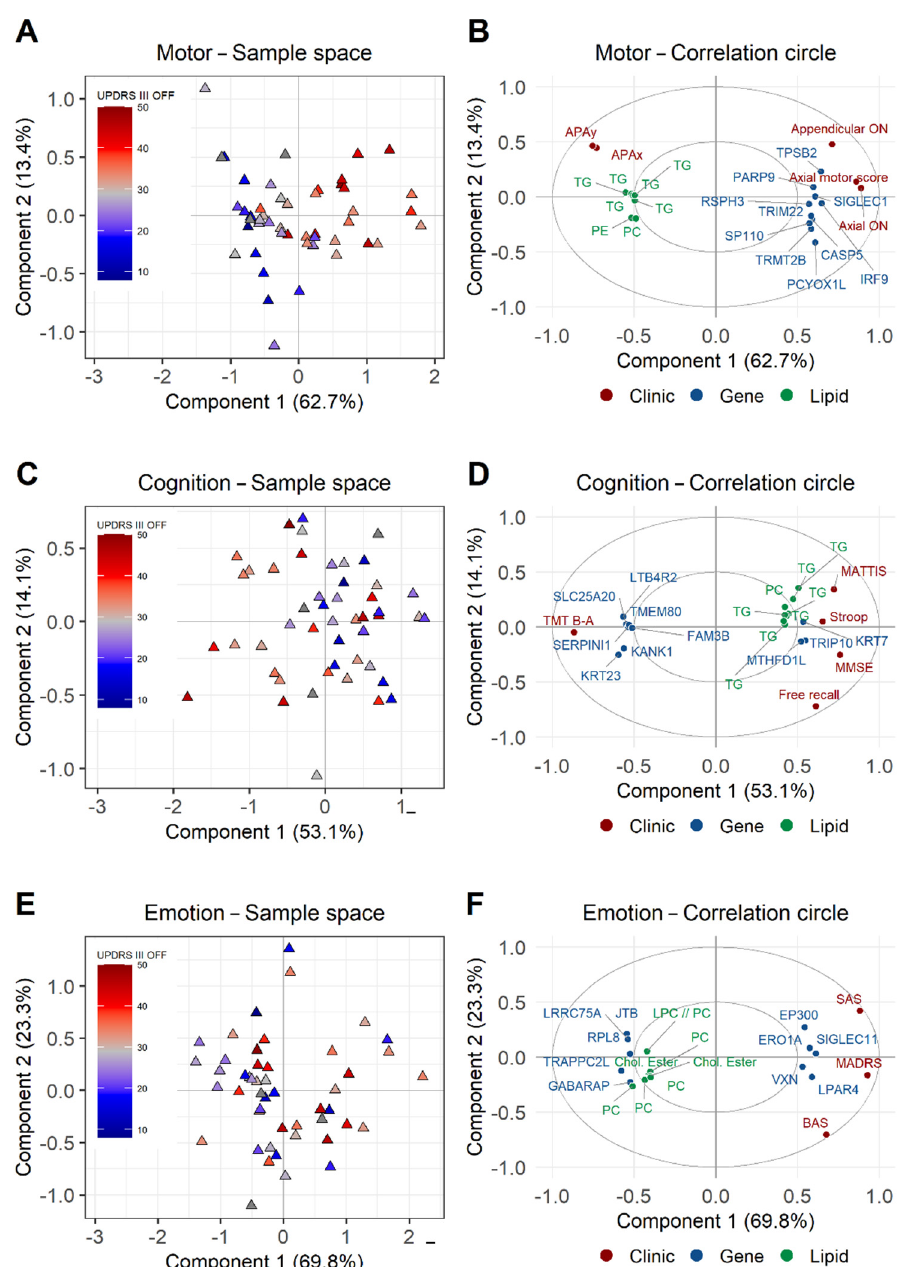
Figure 2. Sample space (left: A , C , E ) and correlation circle (right: B , D , F ) plots of the multimodal signature of lipids, genes and clinical features for each clinical model: motor ( A , B ), cognition ( C , D ) and emotion ( E , F ). The blue-to-red color gradient applied to the sample spaces is indicative of the increasing severity of motor impairment (UPDRS-III OFF) of the PD patients. The most relevant lipids are represented in green, genes in blue and clinical features in red. The percentages of variance on the components are indicated in parentheses.